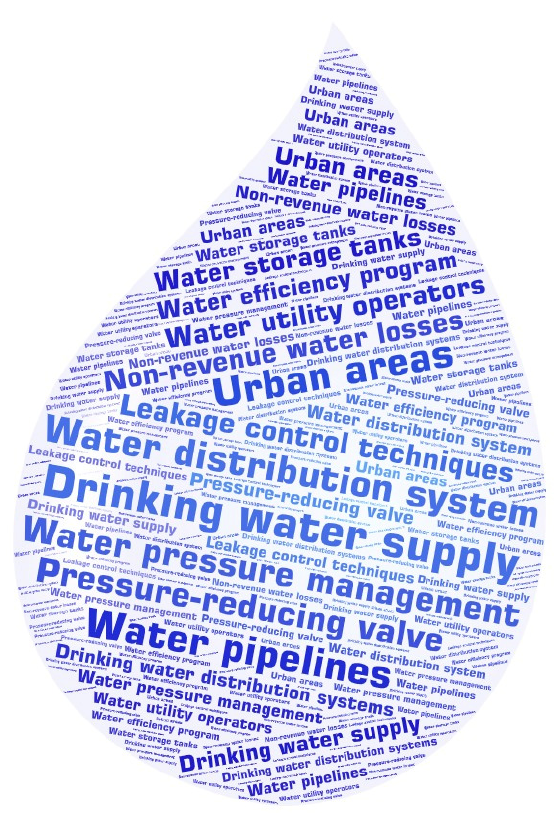
Figure 1. Principal keywords on advances in leakage control and energy consumption optimization in drinking water distribution networks.